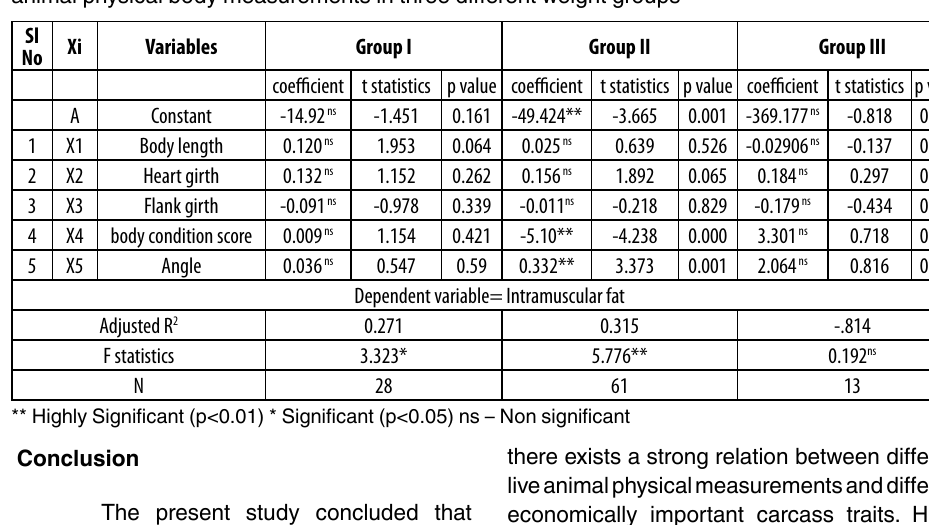
table 8. Regression analysis for developing prediction equation for intramuscular fat using live animal physical body measurements in three different weight